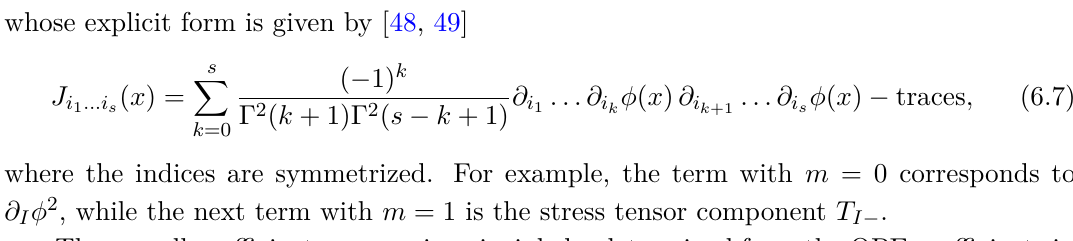
Figure 3 . Setup for the operators in the x + and ~x ⊥ directions in our simplifying limit. whose explicit form is given by [48,